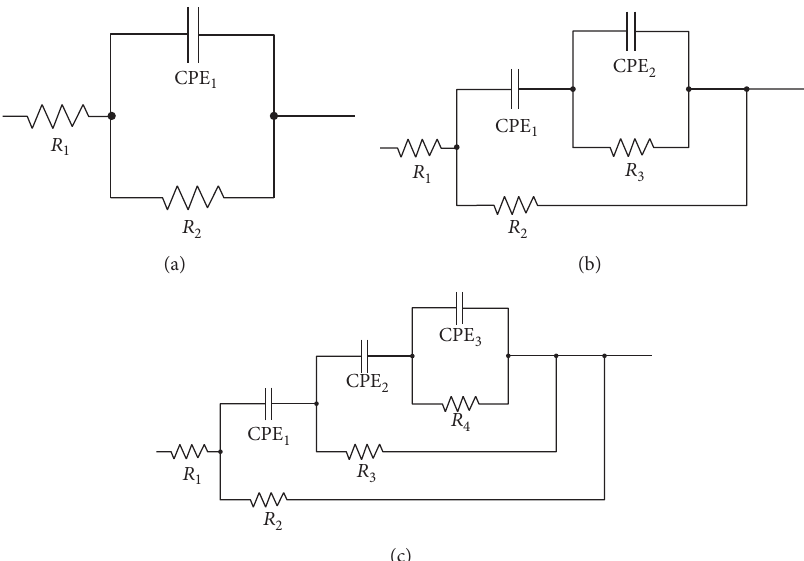
Figure 4: Equivalent circuits employed for curve fitting for the untreated sample (a), PEO coated sample (b), and sealed samples (c).